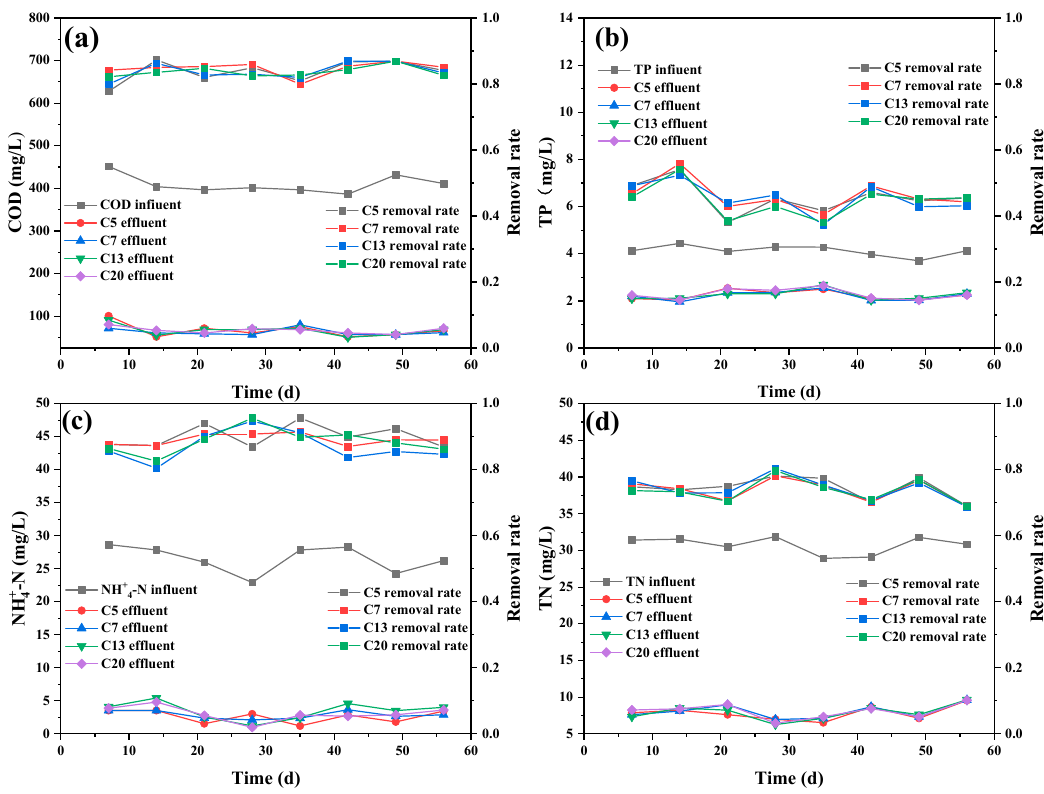
Figure 5. Pollutants removal in the CMBR by different membranes: ( a ) COD; ( b ) TP; ( c ) NH4 + -N; ( d ) TN.